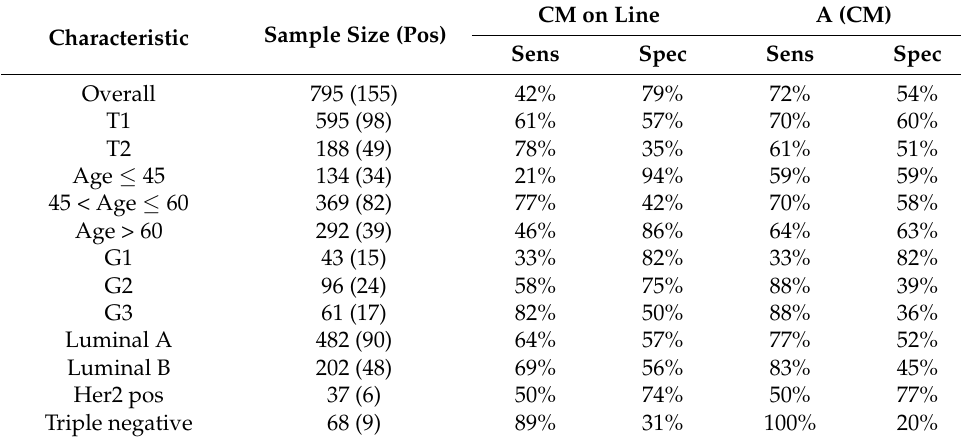
Table 3. Median values of classifiers performances evaluated on the hold-out training set in stratifica- tion